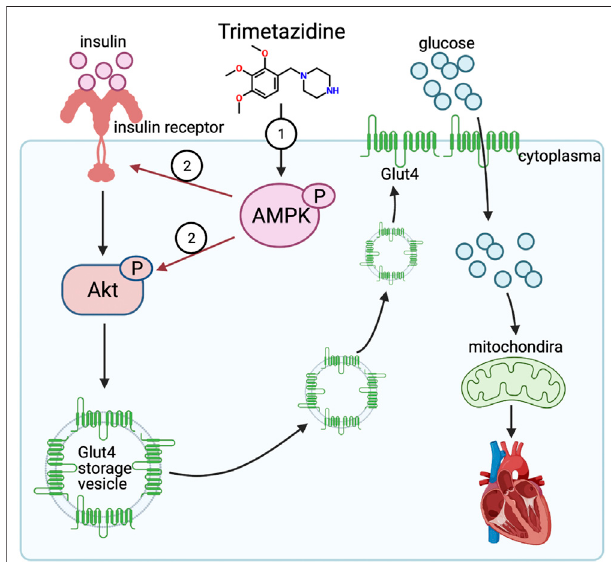
FIGURE 7 | Trimetazidine activates insulin signaling pathway evident by enhanced expression of insulin receptor and activated Akt via AMPK, thus elevating the glucose uptake rate and improving the mitochondrial function against pressure overload induced heart